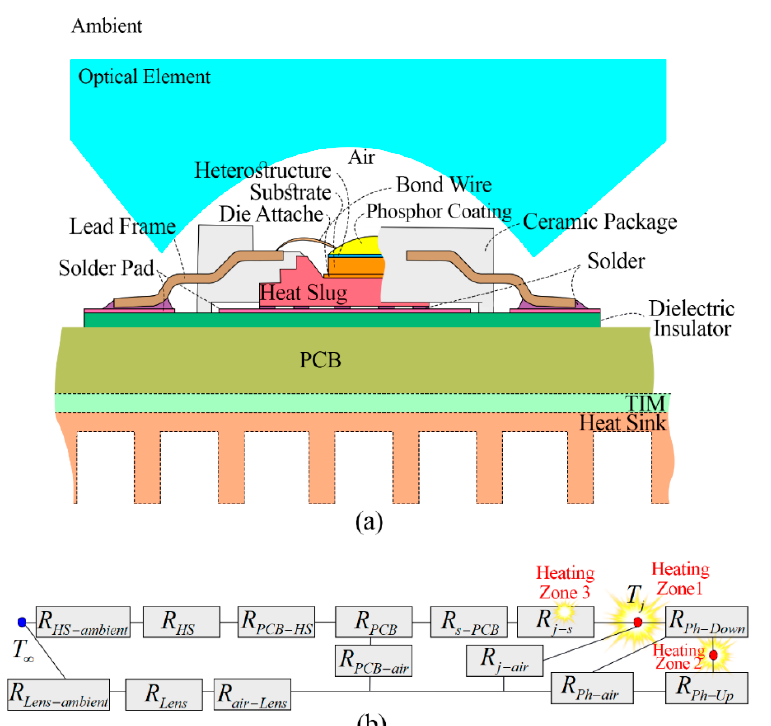
Figure 1. ( a ) Schematic overview of the package and structure of a typical LED luminaire and corresponding ( b ) thermal resistance network with main heat generation zones indicated by heat generating zones 1 to 3. R j-s and R j-air indicate thermal resistance from the junction to the solder point and to air (trapped air inside the luminaire), respectively. R s-PCB indicates thermal resistance introduced from package mount to PCB. R PCB , R PCB-HS , and R PCB-air are thermal resistance of the package, interfacial thermal resistance from PCB to heat sink, and convection resistance from PCB to air (air trapped in the luminaire), respectively. R HS and R HS-ambient are the thermal resistance of the attached heat sink and the convection from the heat sink to the ambient air, respectively. In case of having phosphor coating, R Ph-Down and R Ph-up are thermal resistances in the phosphor coating (phosphor generates heat due to thermal quenching and Stokes shift). R air-Lens , R Lens , and R Lens-ambient denote the thermal resistance of hot trapped air to the covering lens, the thermal resistance of the lens itself, and the convection from lens to ambient, respectively.